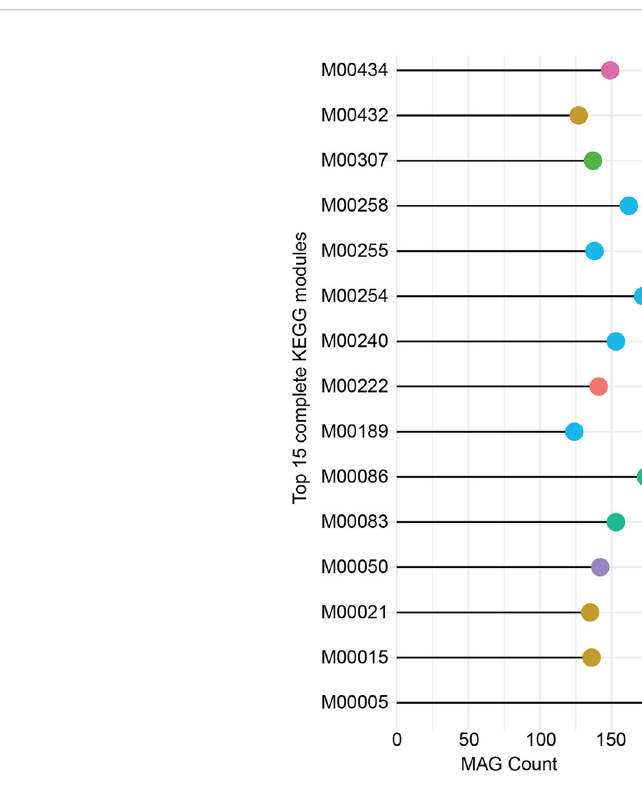
FIGURE 5 | Top 15 complete KEGG pathway modules. Here, the 15 most complete pathway modules and the count of MAGs (in which they are identi fi ed to be 100% complete) are given. The color key indicates the association of the pathway module with the KEGG metabolic pathway categories. Module M00005 was identi fi ed to be 100% complete from more than 150 MAGs and belonged to the Carbohydrate metabolism category of KEGG pathways. M00086, M00254, and M00258 were the three other most prevalent metabolic